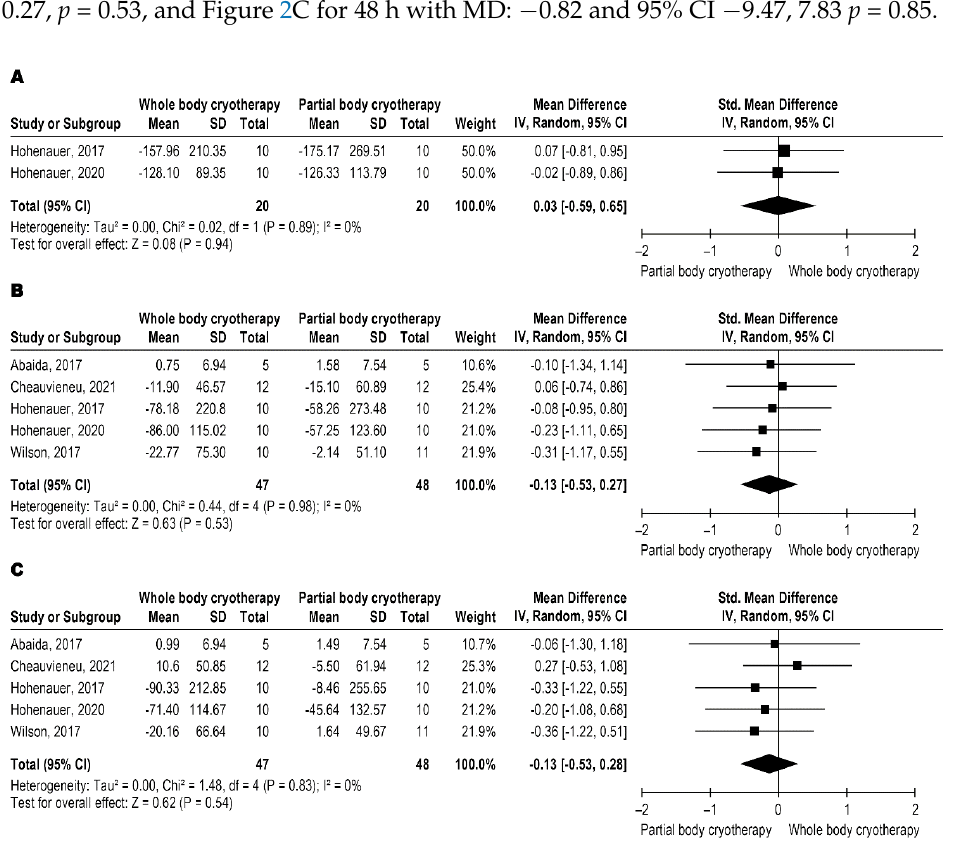
According to GRADE, the three studies that analyzed jump performance used the vertical jump test as an outcome, represented by the height of the jump, with very low quality (downgraded by inconsistency and imprecision). WBC and PBC modalities have similar effects on VJP (Figure 3A – C). VJP data were analyzed in three different follow- ups, immediately post-intervention and 24 and 48 h after the intervention. The meta-anal- ysis results are shown in Figure 3A for immediately post with SMD: − 0.20 and CI 95%: − 0.85, 0.45, p = 0.54, Figure 3B for 24 h with SMD: − 0.11 and CI 95%: − 0.73, 0.51, p = 0.54, and Figure 3C for 48 h with SMD: − 0.17 and CI 95%: − 0.79, 0.45, p = 0.59.